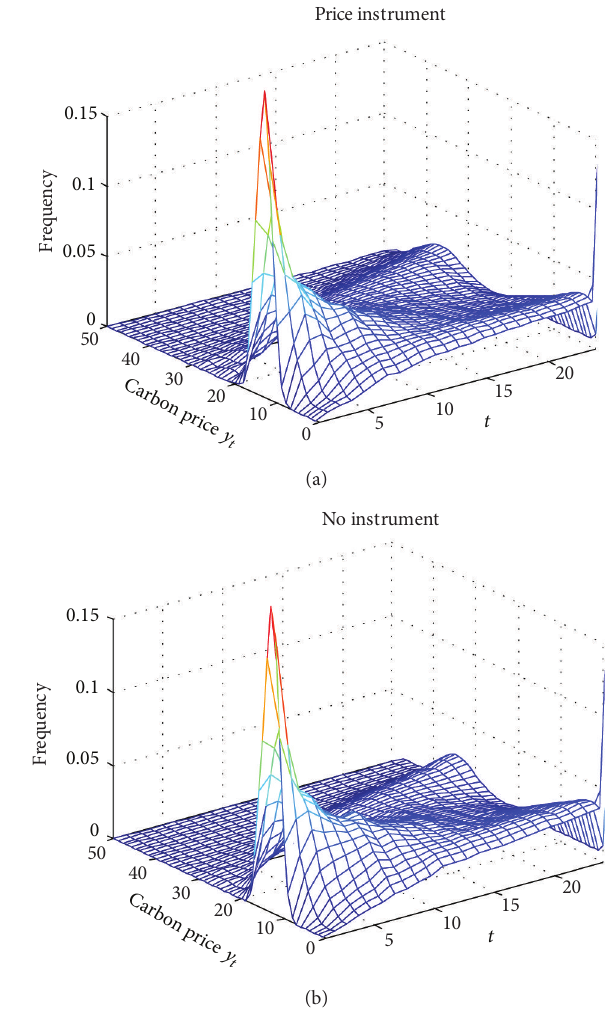
Figure 3: Carbon price frequency distribution diagram of lower threshold regulation using quantity instrument.